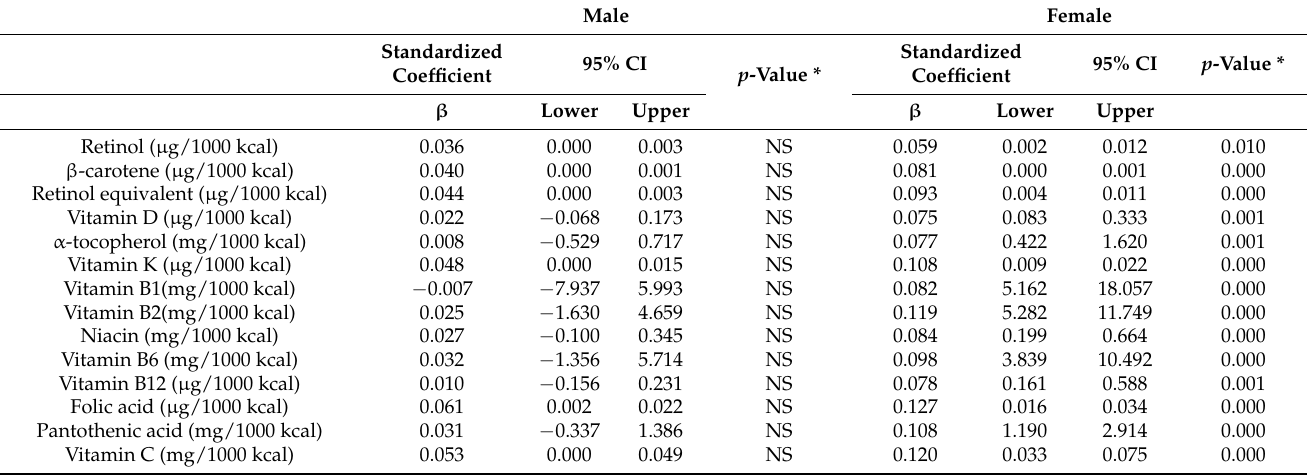
Table 5. Association between nutrient intakes and Physical Component Summary (PCS).